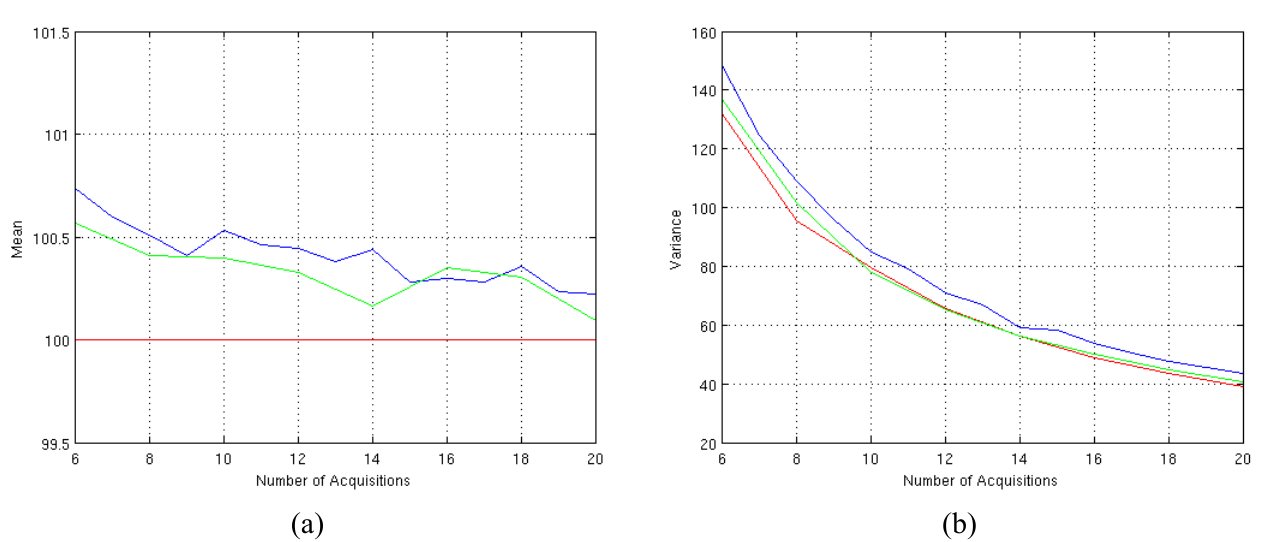
Figure 11 . Performances of the Fast T estimator for different number of available 2 complex-valued data. (a) Mean behavior (the mean of Fast Non Linear LS estimator is plotted in blue, the mean of the classic Non Linear LS estimator is plotted in green and the true value is plotted in red) and (b) variance behavior (the variance of Fast Non Linear LS estimator is plotted in blue, the variance of the classic Non Linear LS estimator is plotted in green and the CRLB value is plotted in red). The results are obtained using SNR = 4, values equispaced in the interval [50–350]  = 60° and N T E